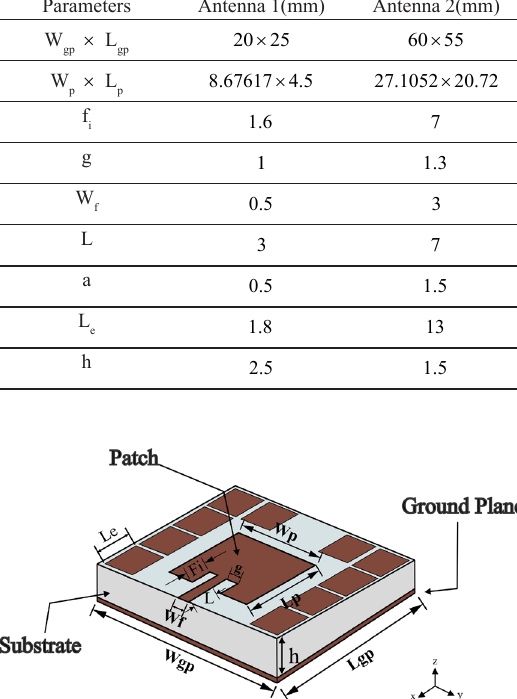
Table 1. Antenna parameters. Antenna 1 is the BiNbO substrate and antenna 2 is the SiO